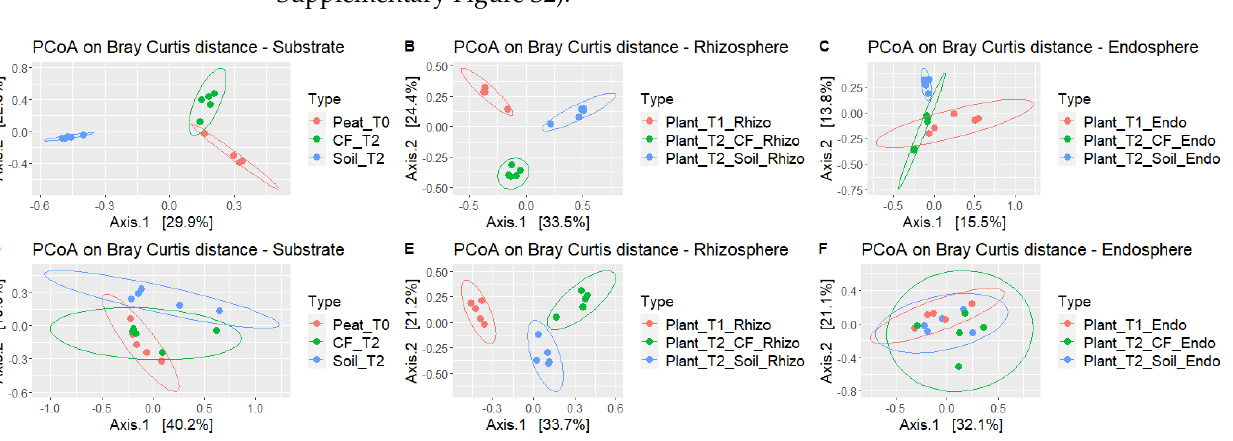
Figure 4. Estimation of the alpha diversity of the microbiome bacterial community ( A , B ); and fungal community ( C , D ) in the different samples of the tomato crop chain based on amplicon sequencing data. The observed Chao1 and Shannon indices were used in the alpha diversity analysis.